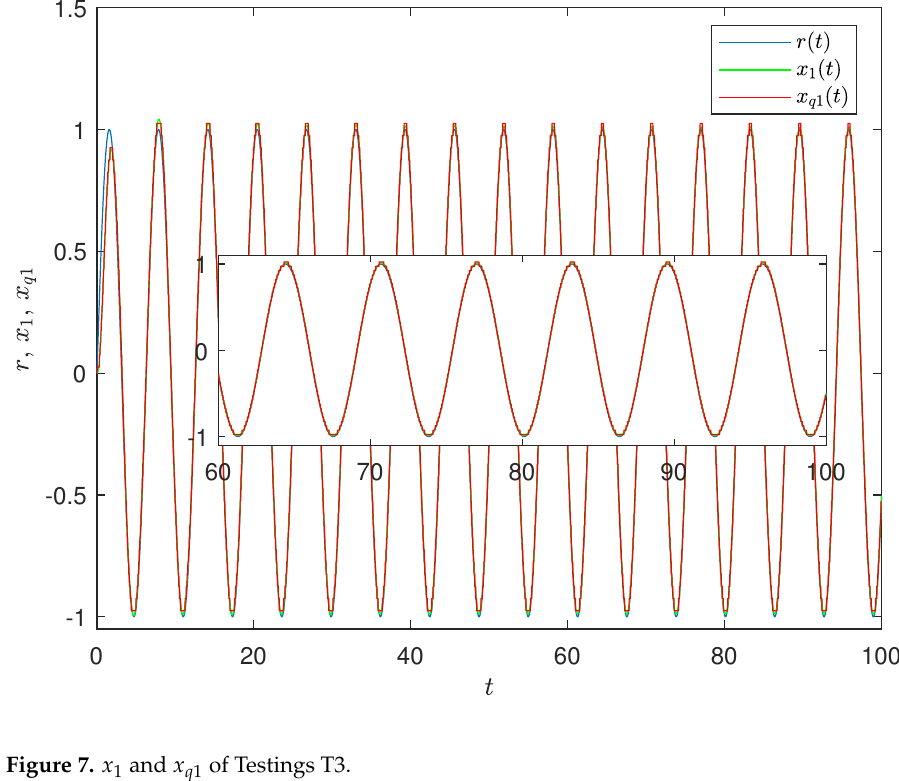
Figure 7. x 1 and x q 1 of Testings T3.